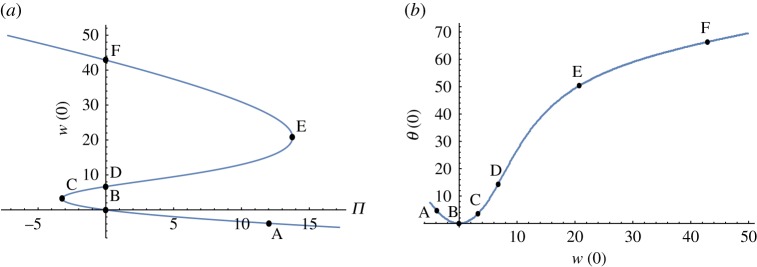
Stationary flows when ε = 0.01 and r = 0.1.